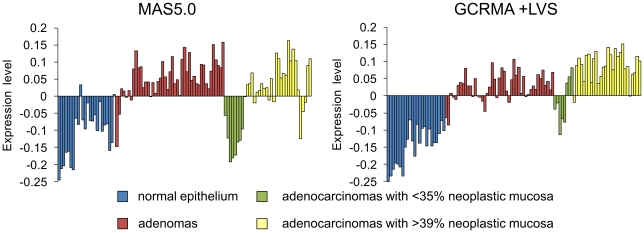
Diagrams of the first statistically independent variability modes extracted from the original normalized with MAS5.0 (left panels) and GCRMA+LVS (right panels) algorithms using SVD, uncovering the microarray data of the whole tissue section samples.